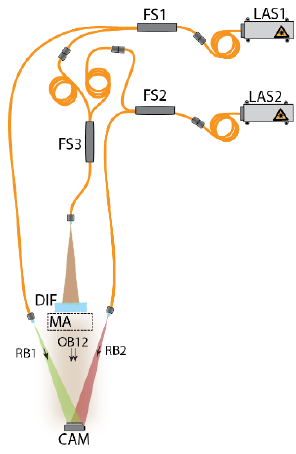
Fig.2. The two-wavelength lensless measuring system: LAS-laser, FS-fiber splitter, DIF-diffuser, MA-measured area, OB-object of investigation, RB-reference beam, CAM-camera .